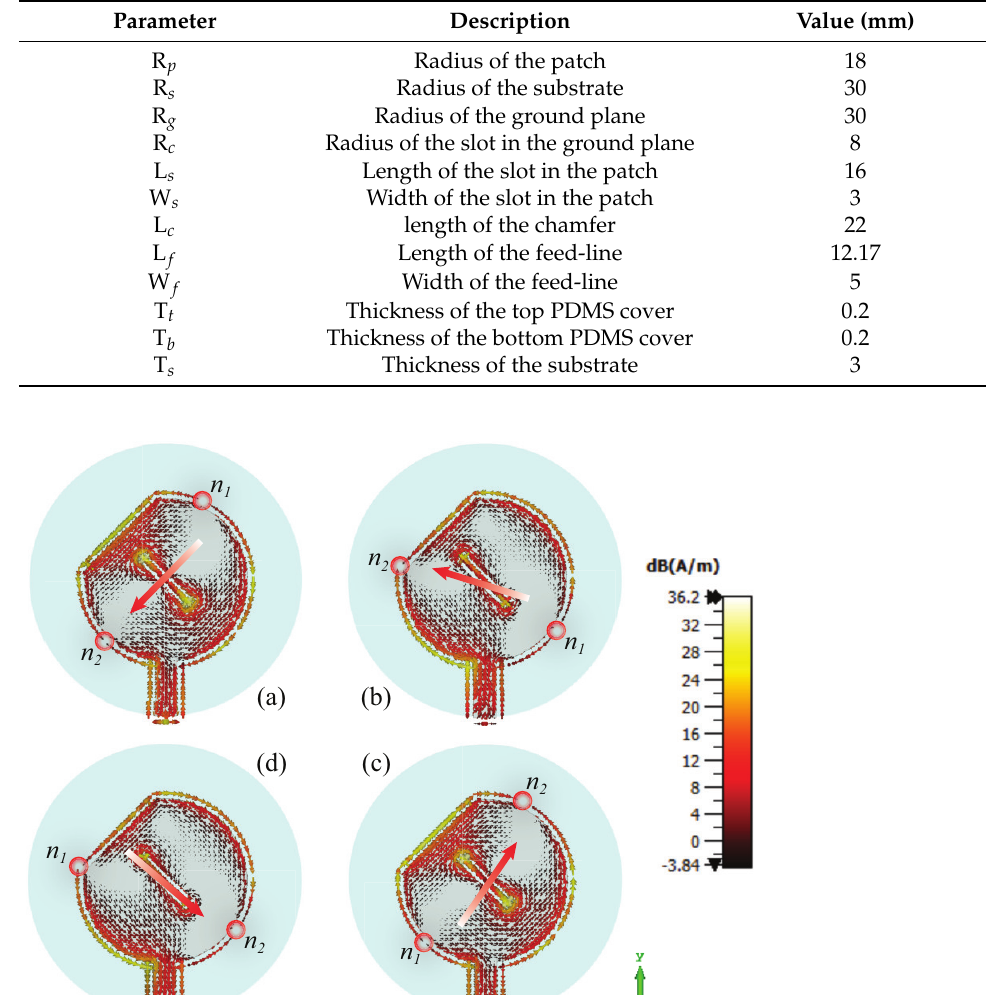
Figure 1. Geometry of the proposed flexible and transparent CP antenna: ( a ) top view, ( b ) side view, ( c ) bottom view. Table 1. Dimensions of the flexible and transparent CP circular patch antenna.